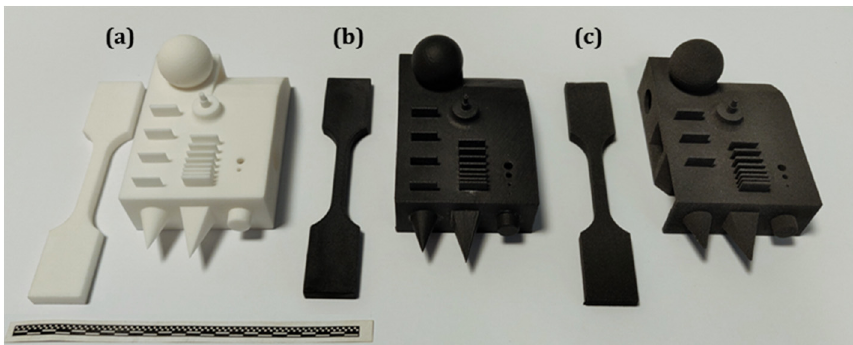
Figure 6. Benchmark and tensile specimens produced using ( a ) Formiga P110 and PA2200, ( b ) Lisa and PA12 Smooth, ( c ) S1 and PA12 Black.